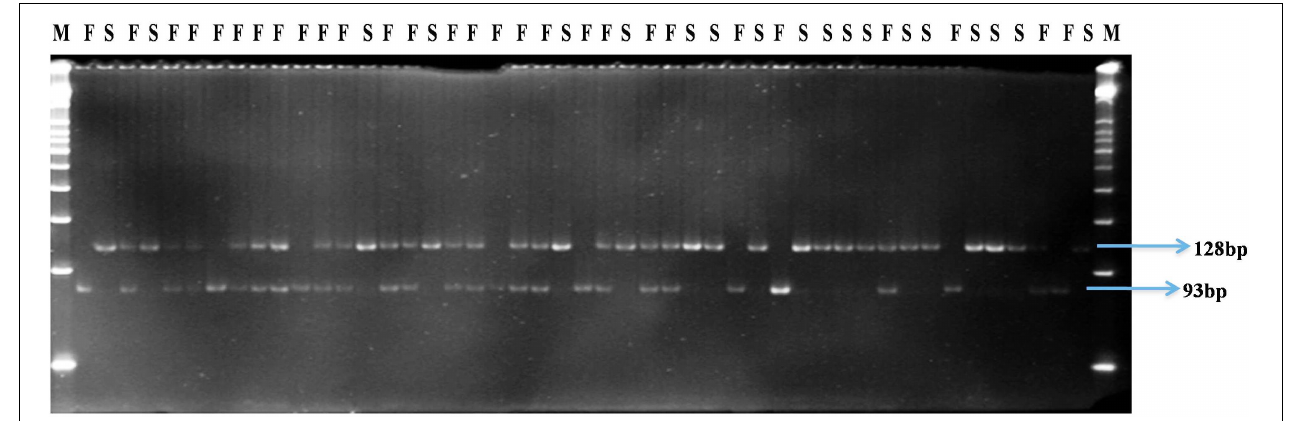
Frontiers in Plant Science |